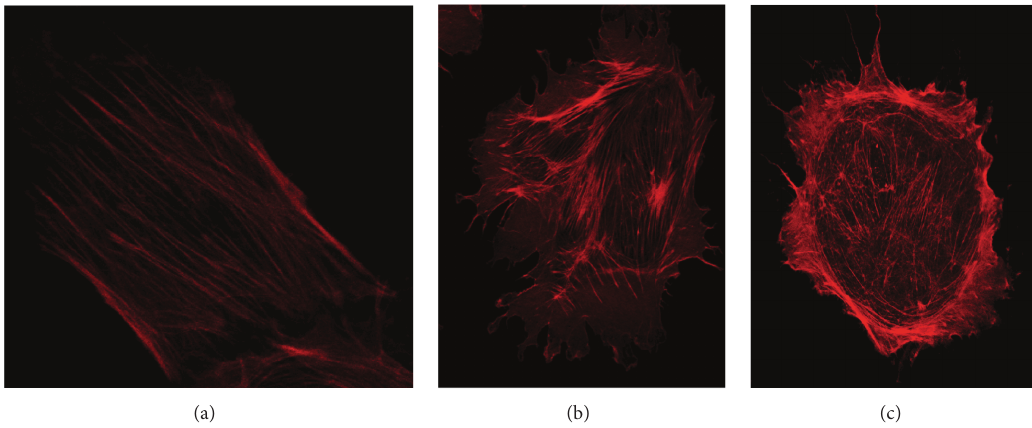
Figure 4: Immortalized podocytes were incubated with either (a) vehicle (b, c) 10ng/mL CLCF-1 for (b) 15 minutes or (c) 30 minutes. Subsequently, cellular actin was stained as described in Methods and Materials and 0.25 𝜇 m sections were visualized by confocal microscopy. Note parallel actin bundles in central portion of control cell (a), compared to the decrease in intensity of central actin bundles and loss of parallel pattern in the cells treated with CLCF-1 (c). Lamellipodia are present in nearly the entire circumference after 30 minutes of incubation